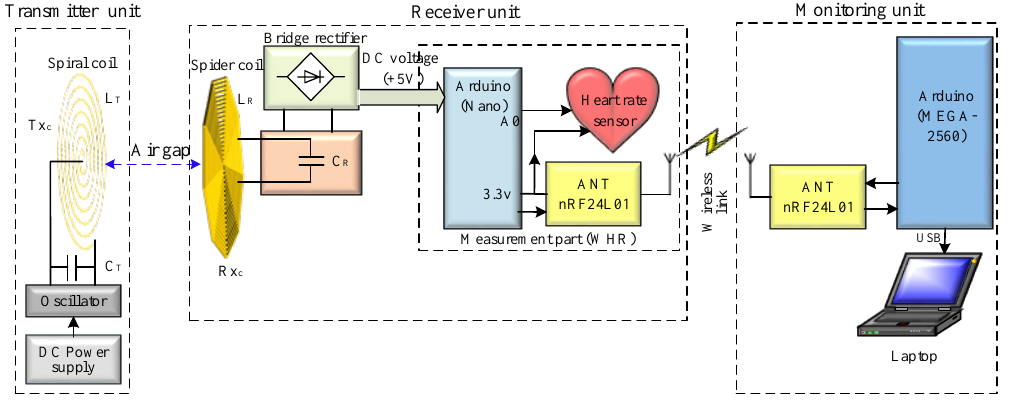
Figure 3. Block diagram of the MRC-WPT-based WHR monitoring system.